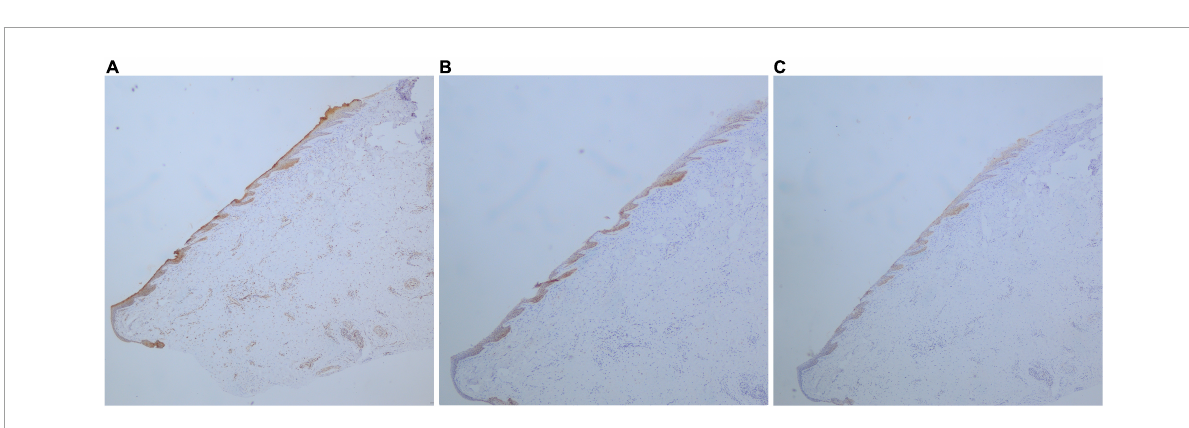
FIGURE4 Longitudinal sections; expression of HK31, HK75, and K6/K16 in the nail bed of the onychopapilloma. (A) Expression of HK31 (DAB staining, SP, × 40). (B) Expression of HK75 (DAB staining, SP, × 40). (C) Expression of K6/K16 (DAB staining, SP, ×